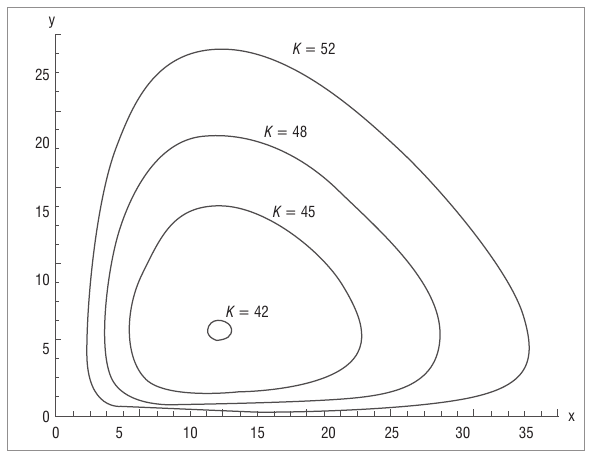
Figure 10: Limit cycles for various values of